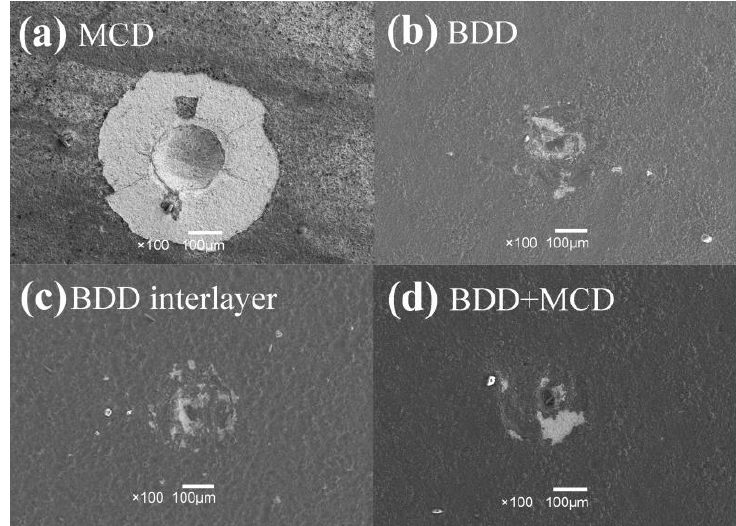
Figure 4. Coating failure modes of MCD ( a ); BDD ( b ); BDD interlayer ( c ); and BDD + MCD ( d ) coatings after indentation